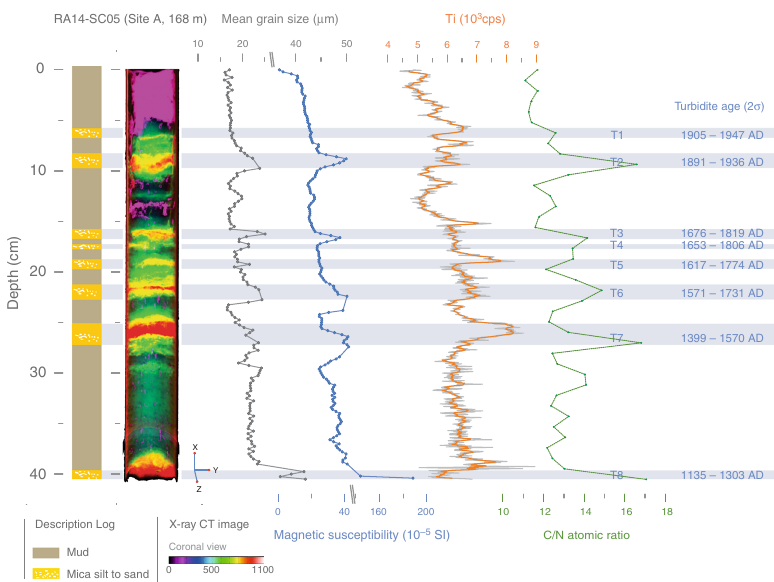
Fig. 2 Identi fi cation of turbidites in sediment core RA14-SC05. From left to right are shown: a synthetic log, 3D coronal view of computed X-ray tomography images in pseudo-colour, mean grain size, magnetic susceptibility, Itrax XRF Ti pro fi le (grey curve: raw data; orange curve: 5 pt-weighted average) and carbon to nitrogen (C/N) atomic ratio. These fi ve parameters were used to identify turbidites T1 to T8. Their ages were extracted from the age-depth model (see